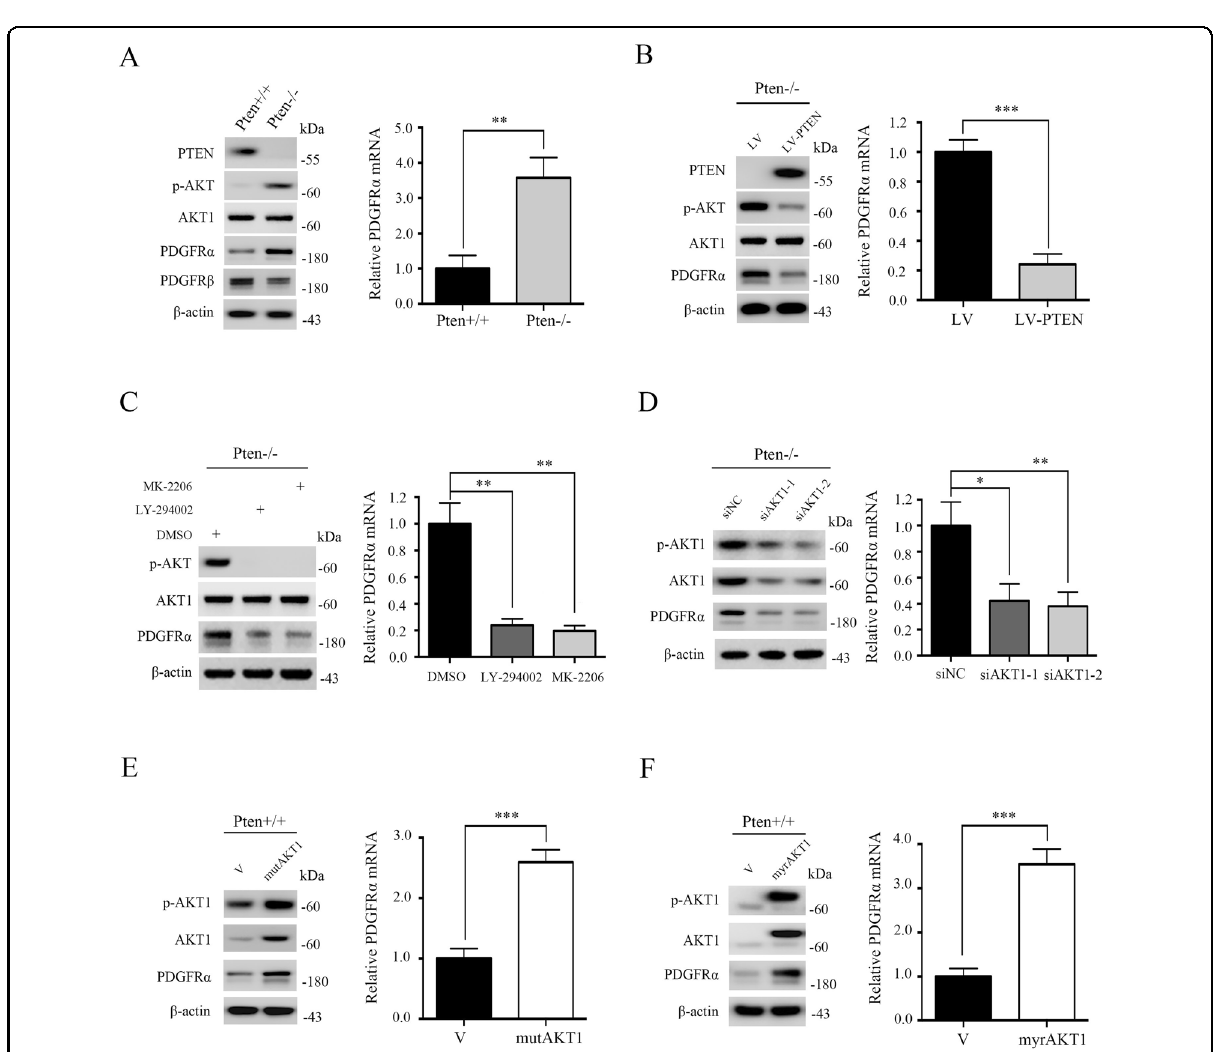
Fig. 1 Loss of PTEN upregulated PDGFR α through the activation of AKT1. A Pten + / + and Pten − / − MEFs. B Pten − / − MEFs were infected with lentivirus harboring a vector encoding human PTEN (LV-PTEN) or the empty vector (LV). C Pten − / − MEFs were treated with LY-294002 (10 μ M) or MK-2206 (2 μ M) for 24 h. D Pten − / − MEFs were transfected with control siRNAs (siNC) or two independent siRNAs against AKT1 (siAKT1-1 and siAKT1-2) for 48 h. E , F Pten + / + MEFs transduced with the retroviruses for AKT1E17K (mutAKT1) ( E ) or myristoylated AKT1 (myrAKT1) ( F ) in pLXIN or its control vector pLXIN (V). A – F Cell lysates were subjected to immunoblotting with the indicated antibodies (left panels). qRT-PCR was performed to detect the mRNA level of PDGFR α (right panels). Error bars indicate mean ± SD of triplicate samples. * P < 0.05; ** P < 0.01; *** P <